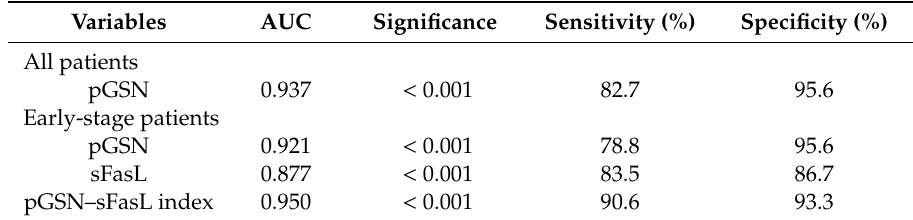
Table 1. Sensitivity and specificity of pGSN, sFasL, or their combination in discriminating between early HNC stage and healthy